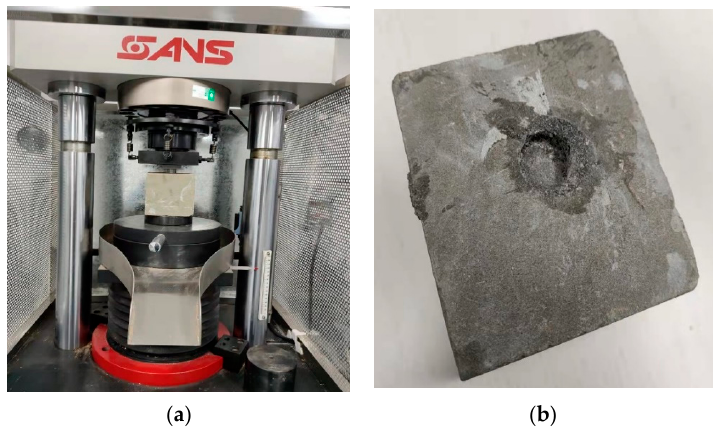
Figure 3. Interface shear test; ( a ) test equipment; ( b ) broken test block.